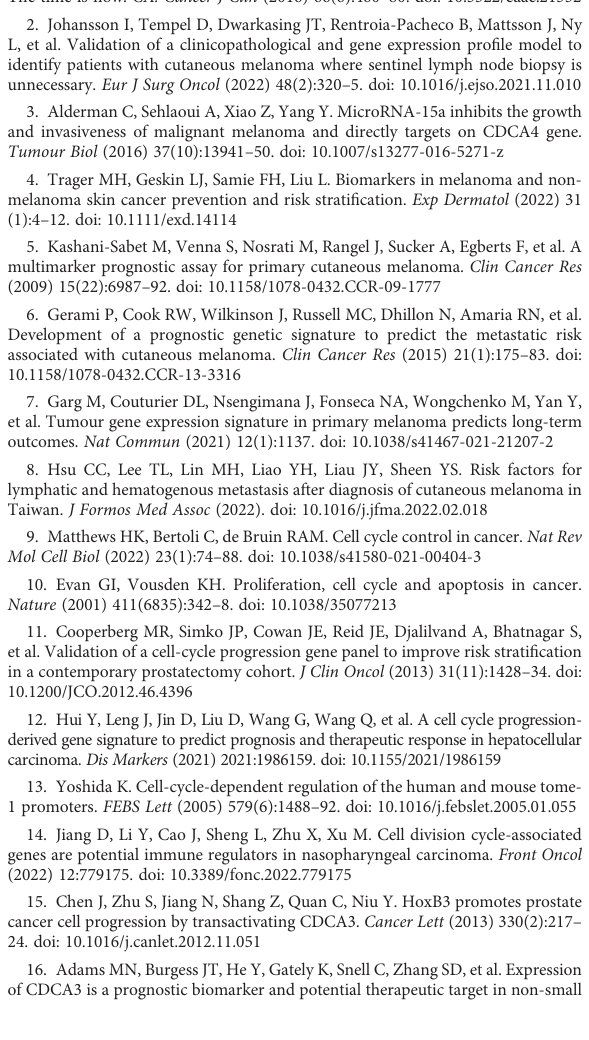
curve to investigate the value of CDCA3 in identifying cutaneous melanoma tissues. SUPPLEMENTARY FIGURE 5 Kaplan – Meier survival plots comparing the low and high expression of CDCA3incutaneousmelanoma. (A – C) SurvivalcurvesofOS,DSS,andPFI between high and low CDCA3 expression in patients with cutaneous melanoma. (D – K) OS survival curves of T stages I – II, N0, M0, pathologic stage I − II, race of white, age > 60, female, Breslow depth< 3 subgroups between high and low CDCA3 expression in patients with cutaneous melanoma. OS, overall survival; DSS, disease-speci fi c survival; PFI, progression-free interval. SUPPLEMENTARY FIGURE 6 Functional enrichment of CDCA3 in cutaneous melanoma. (A) Volcano plots of the DEGs between high and low CDCA3 expression in cutaneous melanoma. (B) Signi fi cantly enriched GO annotations of CDCA3-related genes in cutaneous